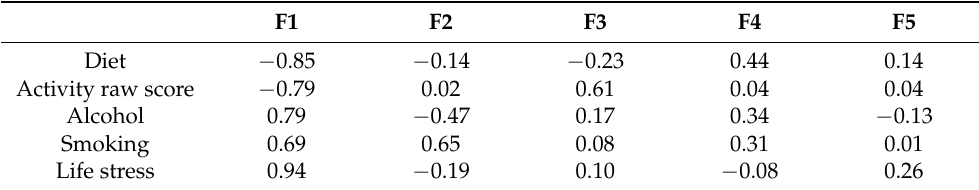
Table 4. Assessment of the dimensionality (factor structure) of the Simple Lifestyle Indicator Ques- tionnaire (SLIQ).